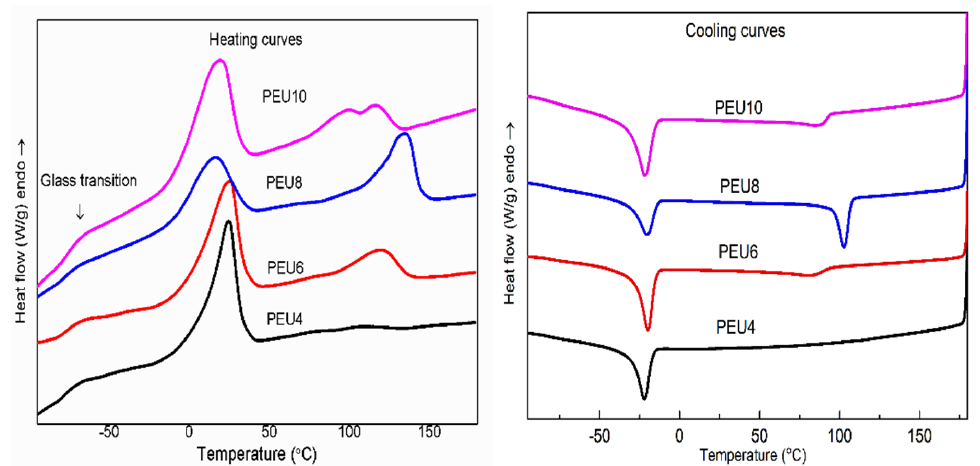
Figure 7. DSC heating scans ( left ) and cooling scans ( right ) of PEU.